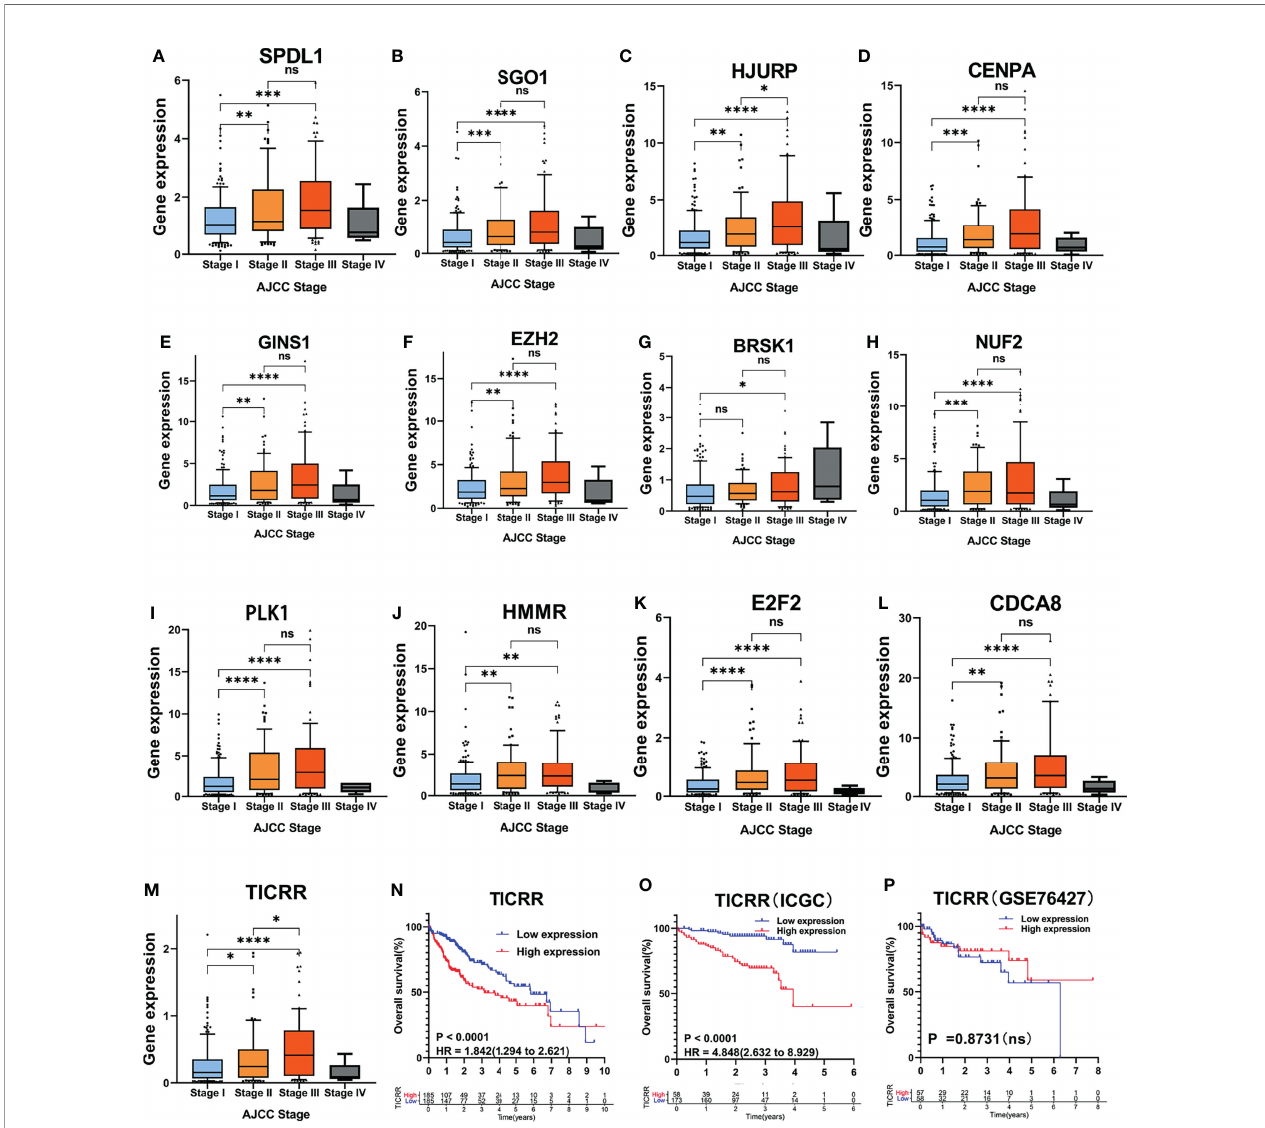
FIGURE 6 | Association of the 13 cell cycle-based genes with AJCC stage in TCGA cohort. (A – M) Expression of 13 cell cycle-based mRNAs in HCC patients with different AJCC stages: Stage I (n = 170), Stage II (n = 85), Stage III (n = 85), and Stage IV (n = 4) from TCGA cohort. *P < 0.05, **P < 0.01, and ***P < 0.001. NS, nonsigni fi cant. (N – P) Kaplan – Meier curves for OS of HCC patients plotted against time (years) based on TICRR expression levels from TCGA cohort (n = 371), ICGC cohort (n = 231), and GSE76427 (n = 115). ****P < 0.0001, OS, overall